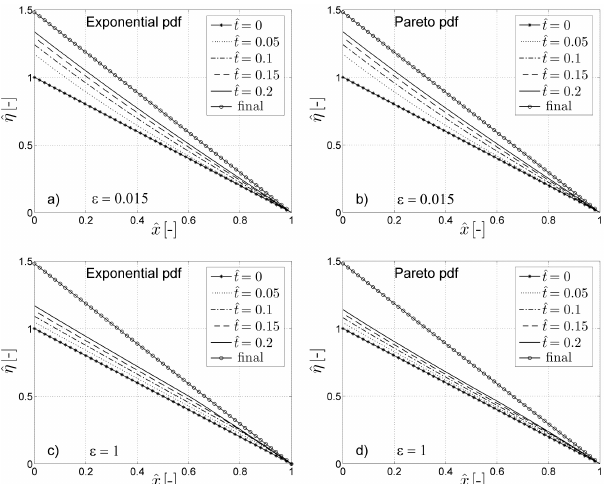
Figure 8. Bed profile evolution for the case ˆ E f = 2. (i) ε = 0 . 015: (a) thin-tailed exponential step length PDF; (b) heavy-tailed Pareto step length PDF ( α = 1 . 5, r 0 = 1 . 5m). (ii) ε = 1 (c) thin-tailed ex-